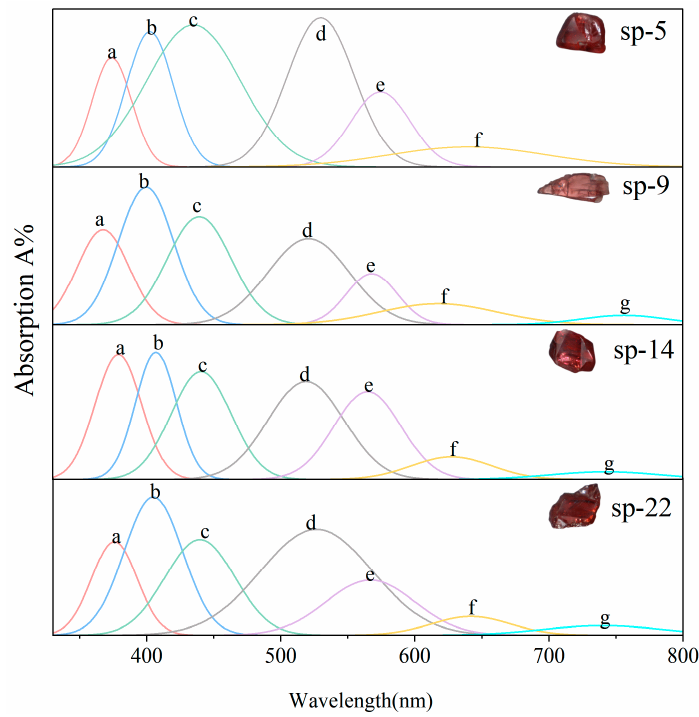
Figure 9. Split peak fitting of UV-Vis absorption spectra of chromium–vanadium-bearing spinel.